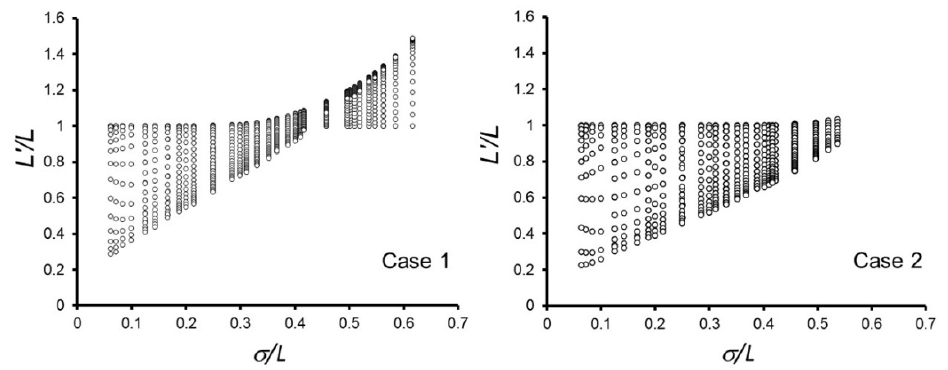
Figure 10. Behaviors of L with respect to d in Cases 1 and 2. The ranges of L ′ for a variety of σ values are shown, and these parameters are normalized by L . Lengthwise sets of dots represent L ′ calculated for a given σ and various values of d .